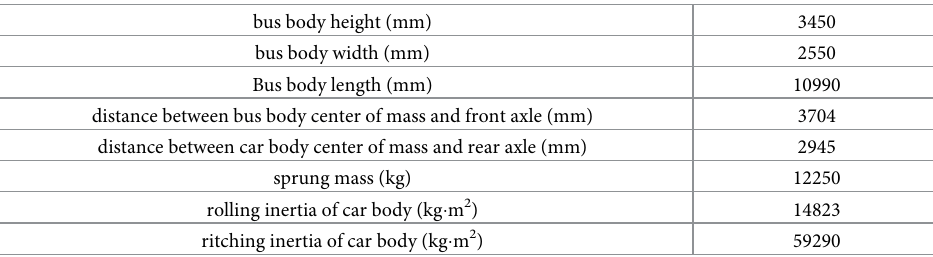
Table 1. Performance parameters of leading model.